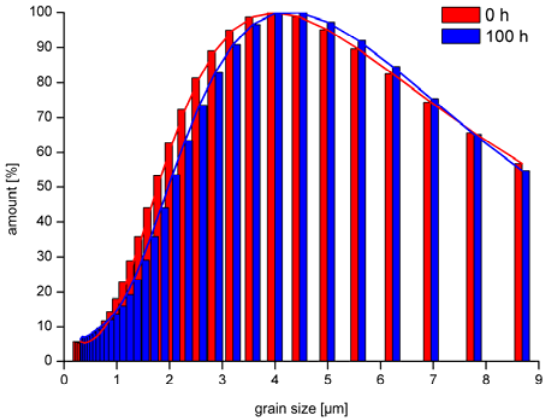
Figure 9. Grain size of the supporting material before and after a stress test of 100 h under reaction conditions (150 °C, 800 rpm, 100 mL H 2 O) measured by laser